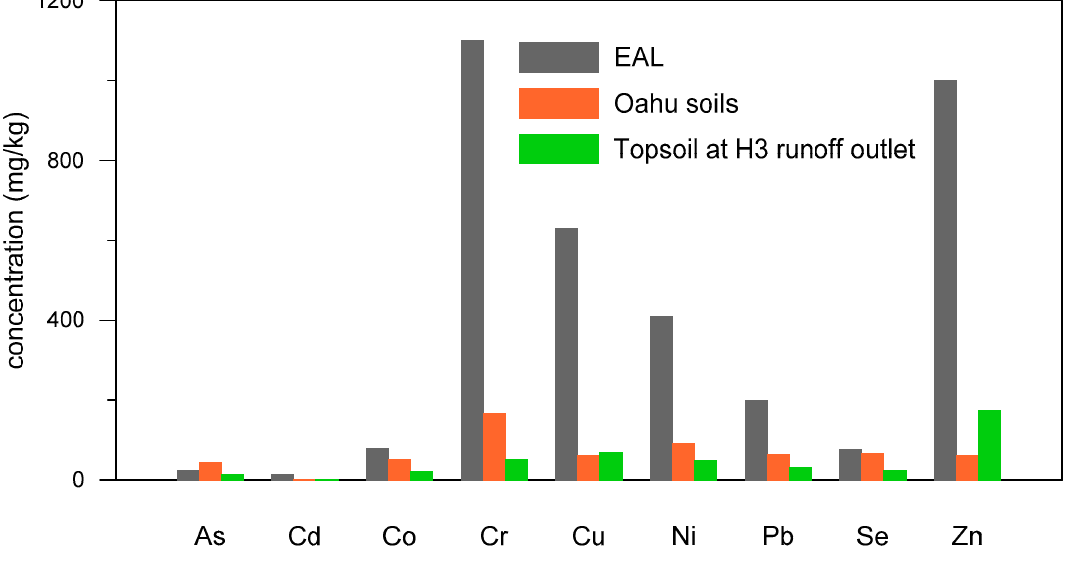
Figure 4. Median of observed concentrations of heavy metals in Oahu soils, topsoil at H3 runoff outlet, and environmental action